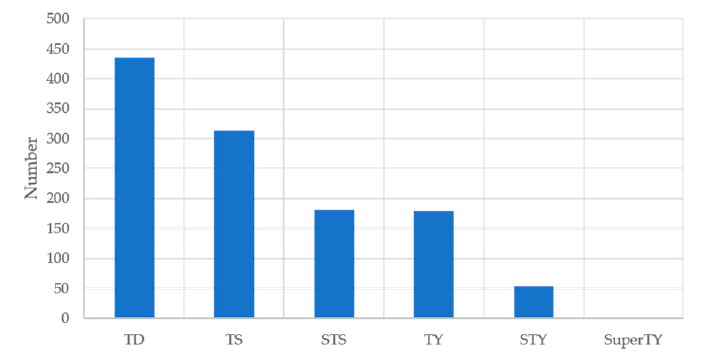
Figure 8. Frequencies of tropical cyclones of di ff erent intensities in the South China Sea from 2006 to 2012. TD: Tropical depression; TS: tropical storm; STS: severe tropical storm; TY: Typhoon; STY: Severe typhoon; SuperTY: Super typhoon.